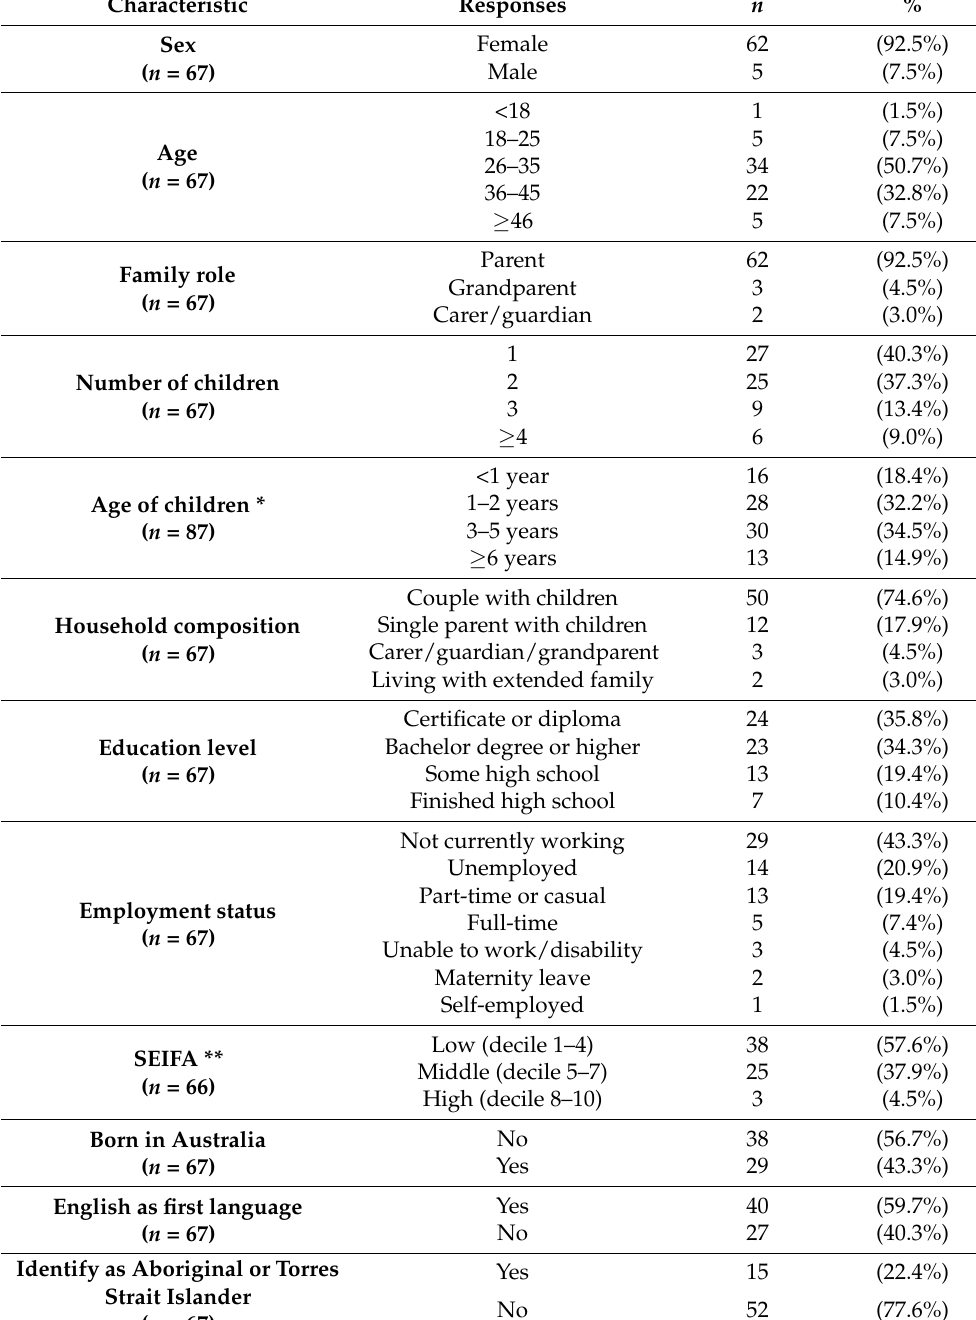
Table 1. Characteristics of parents attending focus